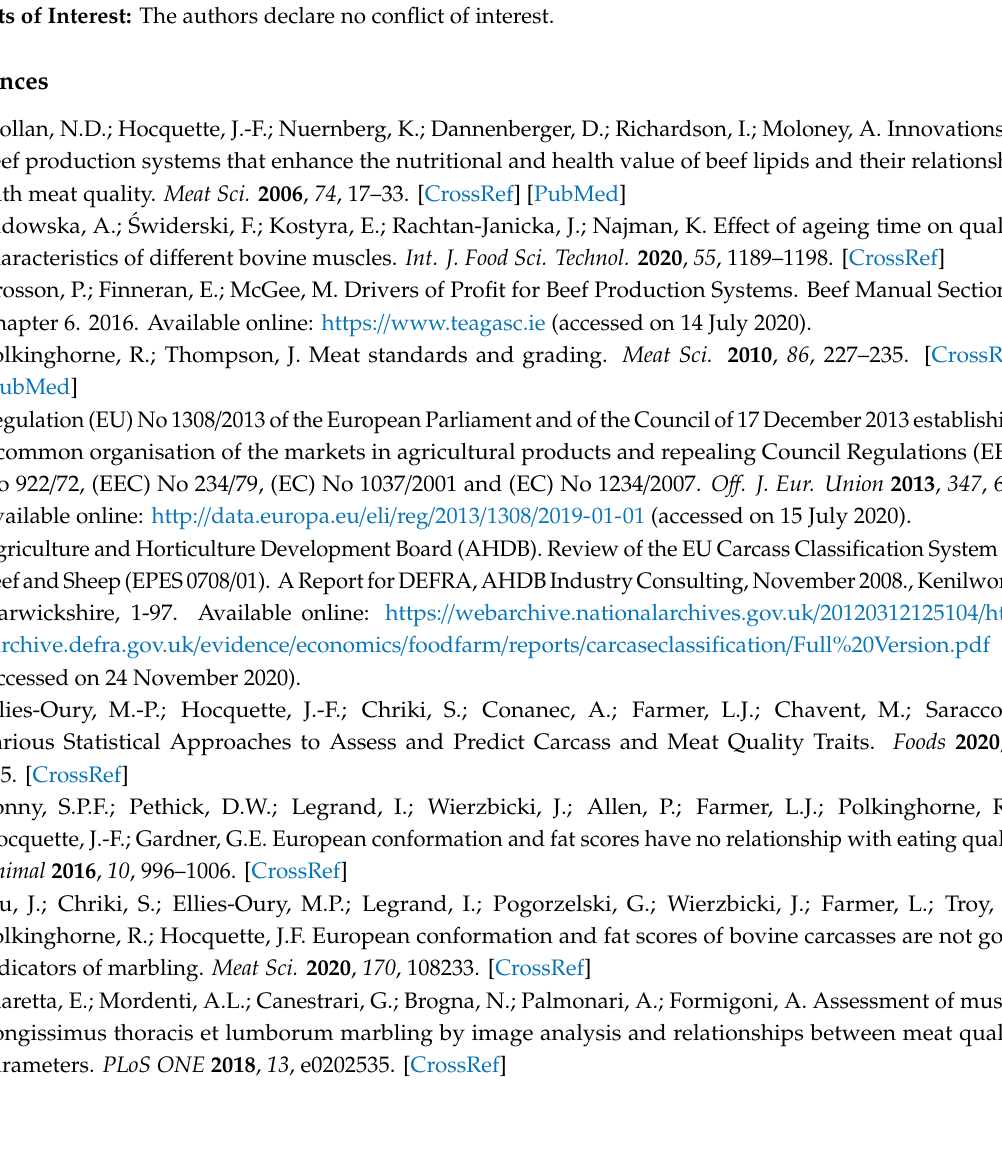
Table S1: Number of carcasses (counts) classified for their muscle conformation in each breed and region and the relative